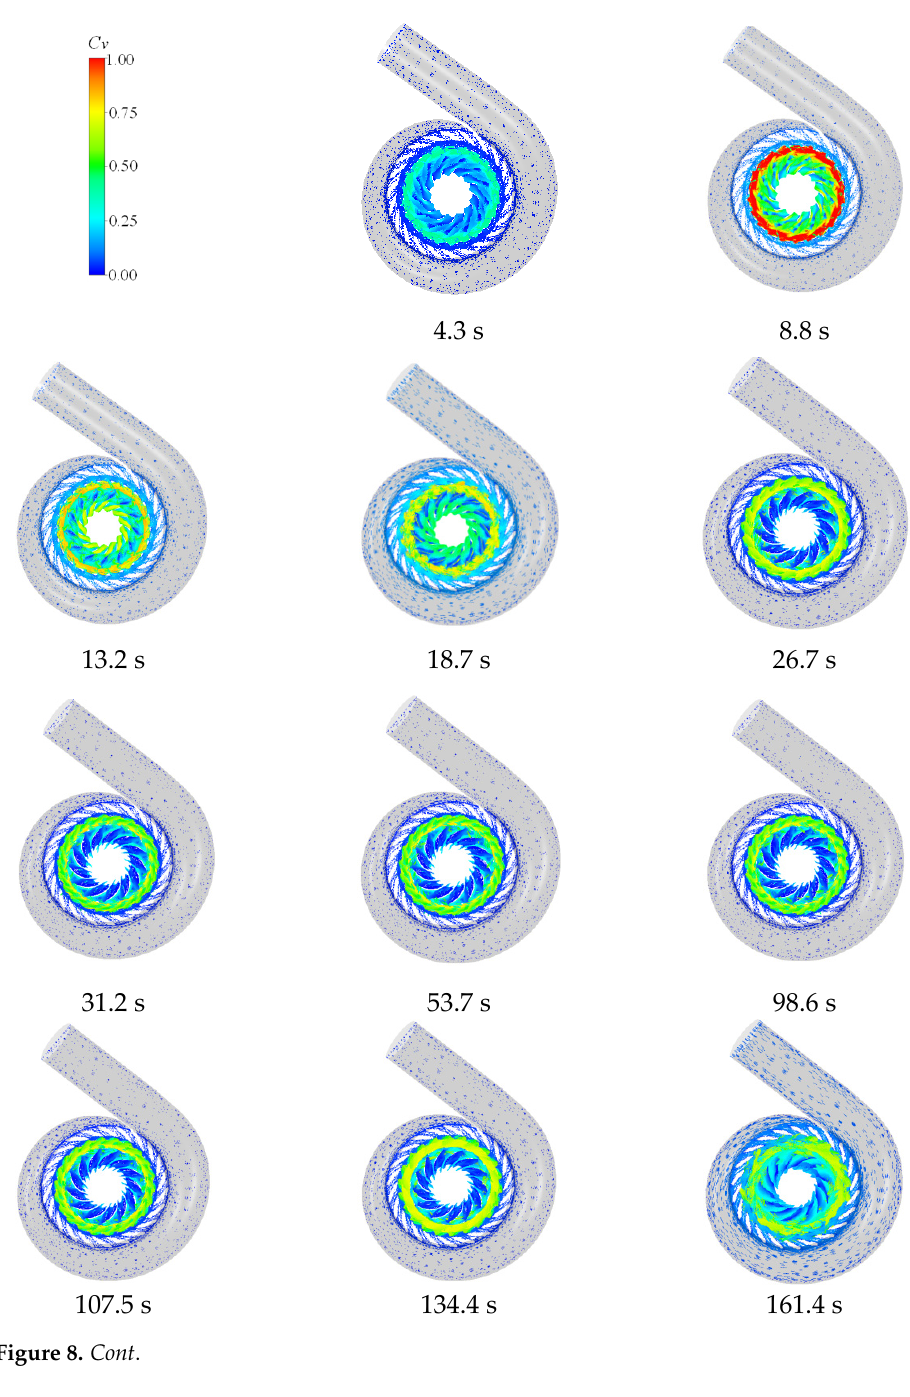
197.3 s Figure 8. The internal flow characteristic of the PT unit during turbine start-up.